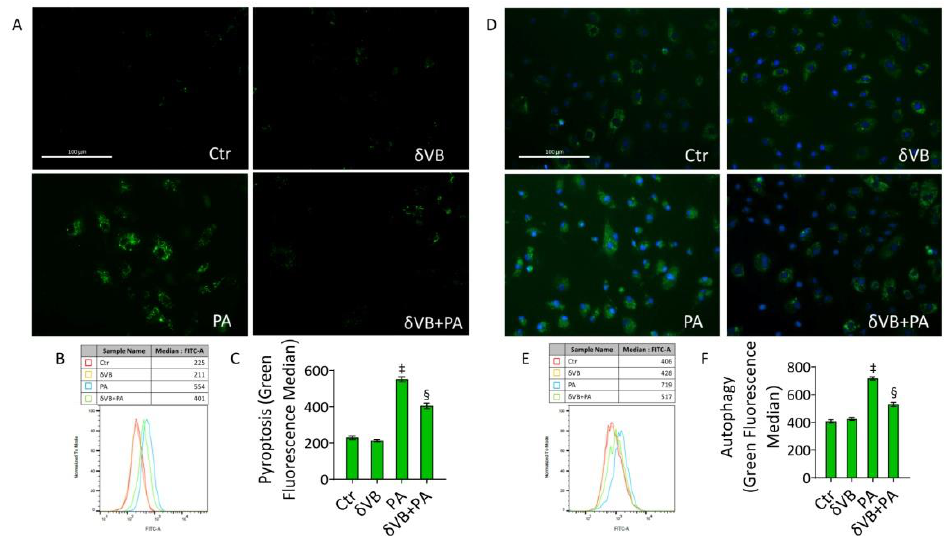
Figure 8. δVB effects on PA -induced pyroptosis and autophagy. Representative images by fluores- Figure 8. δ VB effects on PA-induced pyroptosis and autophagy. Representative images by fluores- cence microscopy and flow cytometry analysis of ( A - C ) pyroptosis and ( D - F ) autophagy, expressed cence microscopy and flow cytometry analysis of ( A – C ) pyroptosis and ( D – F ) autophagy, expressed as green median fluorescence ± SD ( n = 3), in EC exposed for 48 h to 0.5 mM δVB, 0.5 mM PA (PA) , as green median fluorescence ± SD ( n = 3), in EC exposed for 48 h to 0.5 mM δ VB, 0.5 mM PA (PA), or pretreated for 16 h with δVB before 4 8 h PA treatment (δV B + PA). Control cells (Ctr) were treated or pretreated for 16 h with δ VB before 48 h PA treatment ( δ VB + PA). Control cells (Ctr) were treated with the corresponding highest volume of HBSS-10 mM Hepes. Scale bars = 100 µm. ‡ p < 0.001 vs. with the corresponding highest volume of HBSS-10 mM Hepes. Scale bars = 100 µ m. ‡ p < 0.001 vs. Ctr; § p < 0.05 vs. PA. Ctr; § p < 0.05 vs.